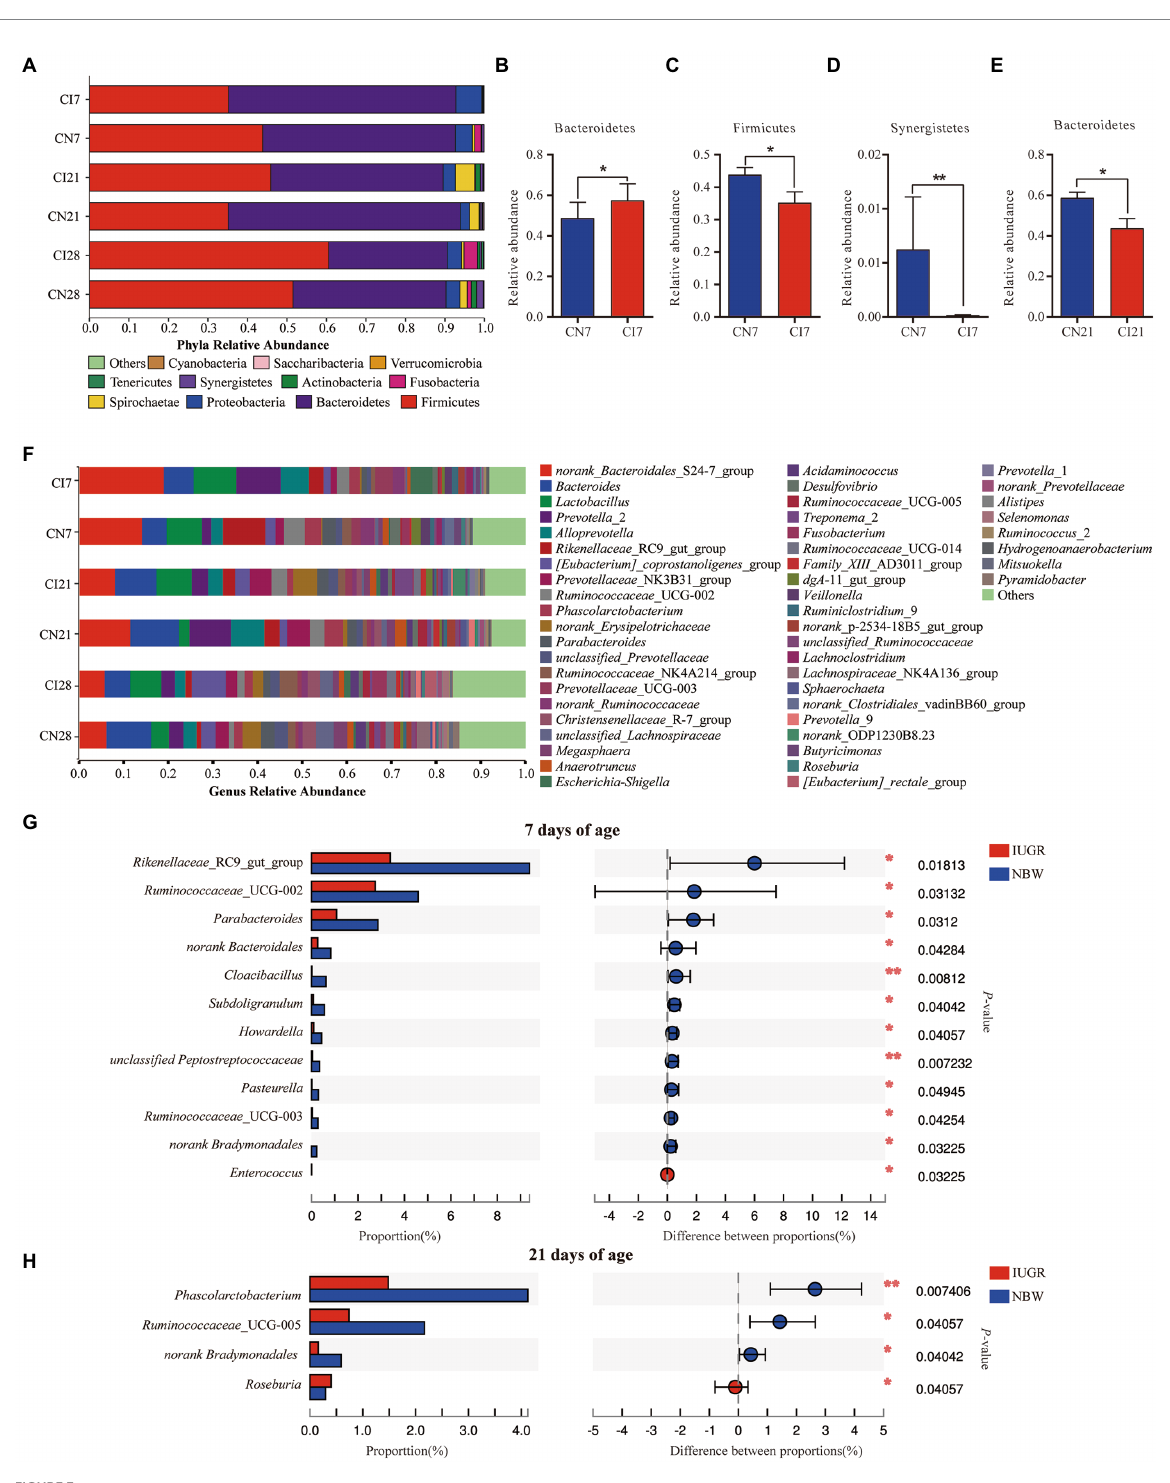
FIGURE 3 The Colonic microbial composition and taxonomic differences between the intrauterine growth restriction (IUGR) and normal birth weight (NBW) piglets at 7, 21, and 28 days of age. (A) The relative abundances of taxa >0.01% at the phylum level are showed by bar plot. (B–E) The taxonomic differences in colonic microbiota at the phylum levels. (F) The top 50 abundant taxa are shown by heatmap. (G,H) The taxomonic differences in colonic microbiota at the genus levels. CI7, CI21, and CI28 represent colonic samples obtained from IUGR piglets at 7, 21, and 28 days of age, respectively. CN7, CN21, and CN28 represent colonic samples obtained from NBW piglets at 7, 21, and 28 days of age, respectively. Red and blue represent the IUGR and NBW piglets, respectively. The data are expressed as means ± SEM ( n = 8). * p < 0.05; ** p <